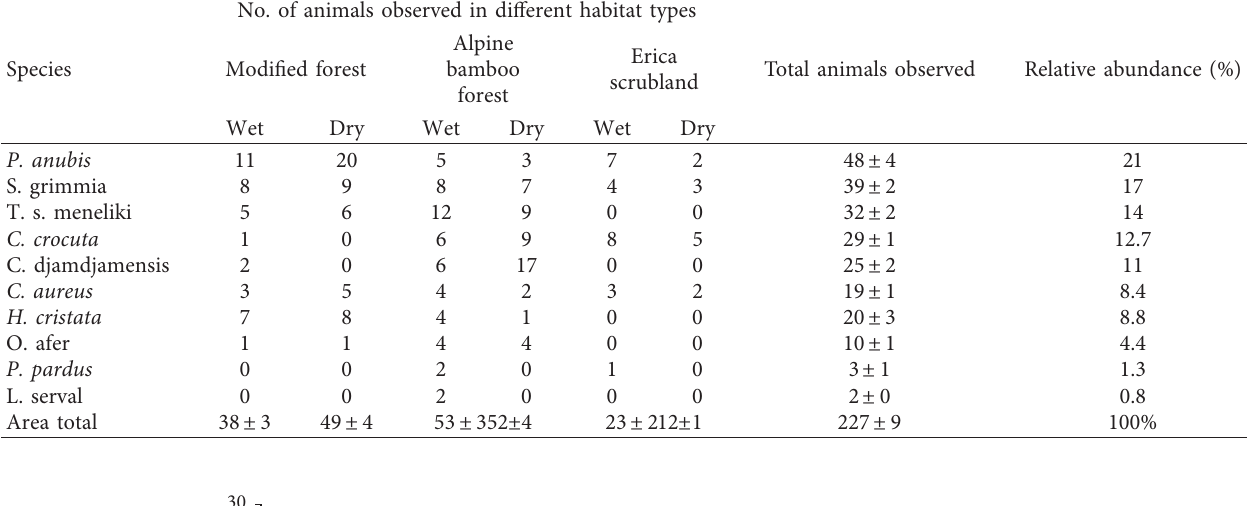
Table 4: Relative abundance of large wild mammals among different habitat types of Geremba Mountain, southern Ethiopia.